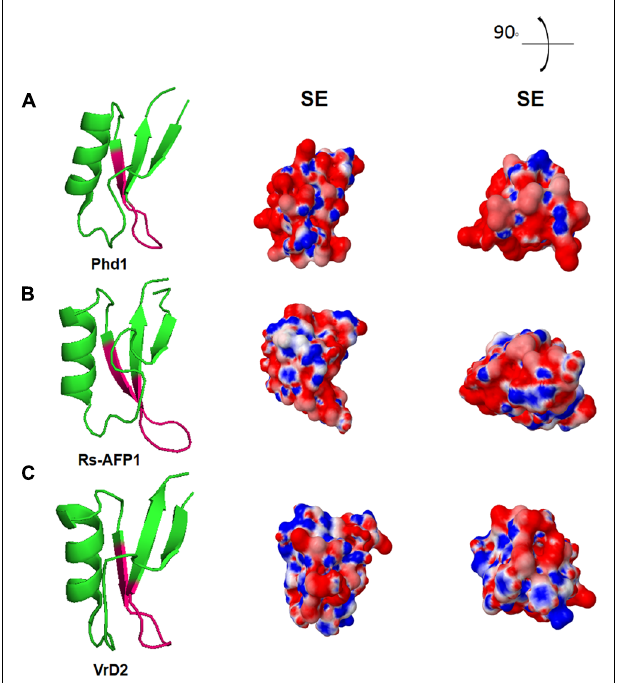
FIGURE 3 | Electrostatic surface of three plant defensins under vacuum environment. Three-dimensional structures of (A) Phd1; (B) Rs-AFP1; (C) VrD2. SE: solvent excluded electrostatic surface. 90 ◦ and the illustration and the right top of the figure indicates the angle deviation for new visualization of the peptides structures. All figures were designed using PyMol Molecular Graphic SystemVersion 1.2r3pre, Schrödinger,